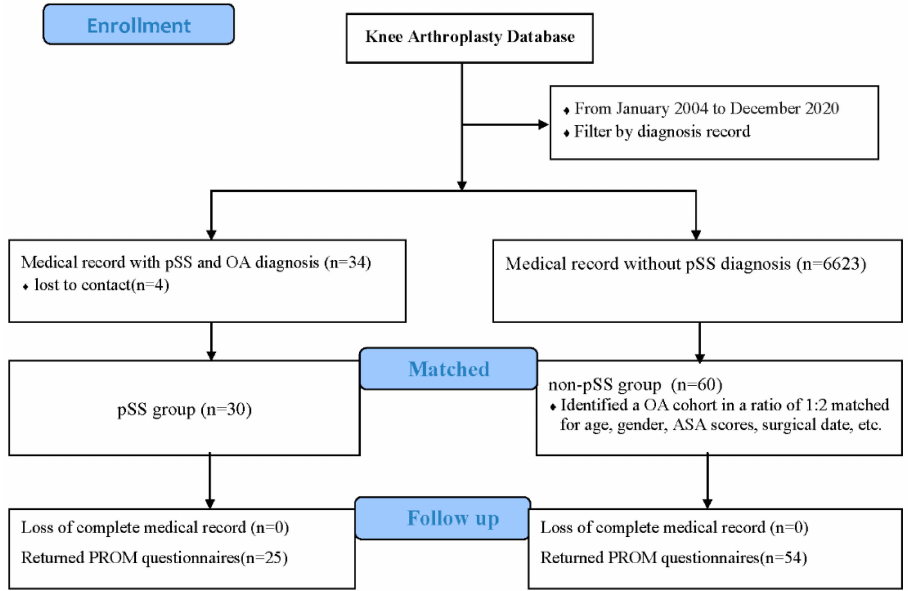
Figure 1. Flow chart. Abbreviations: pSS = primary Sjögren’s syndrome; OA = osteoarthritis; PROM = patient-reported outcome